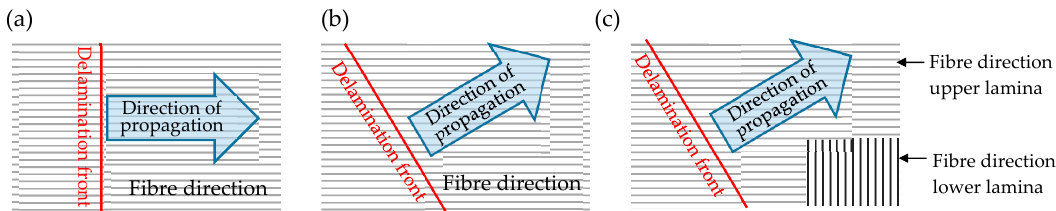
Figure 1. Schematics of potential scenarios of delamination front propagation: ( a ) delamination is between laminae of the same fibre orientation with the direction of propagation being along the fibres; ( b ) delamination is between laminae of the same fibre orientation but the direction of propagation is different from the fibre direction; and ( c ) delamination between laminae of the different fibre orientations.